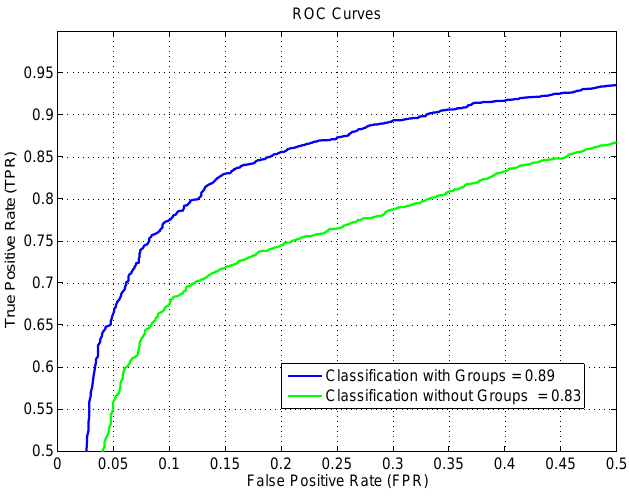
Classification with Groups = 0.89 Classification without Groups = 0.83